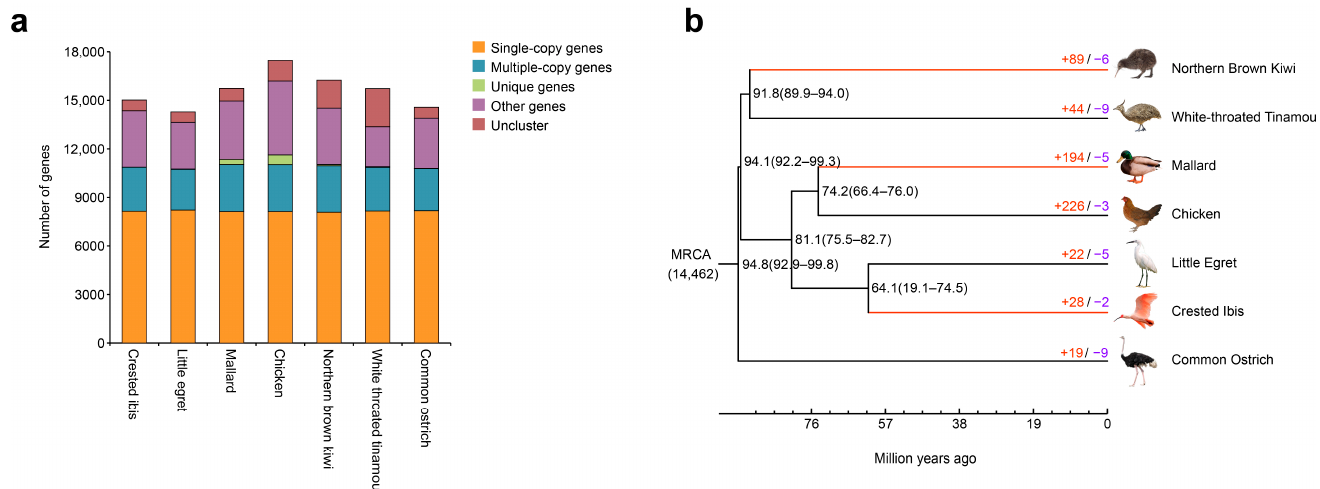
Figure 1. ( a ) Gene families clustering results of all species. ( b ) Time tree construction, and expansions and contractions of gene families of each species. Black numbers at nodes were divergence time between related branches, and 95% confidence intervals were followed (in parentheses). Three tactile-foraging branches were in red, and the number of genes expansions (+, red) and contractions ( − , purple) were also shown on each branch.